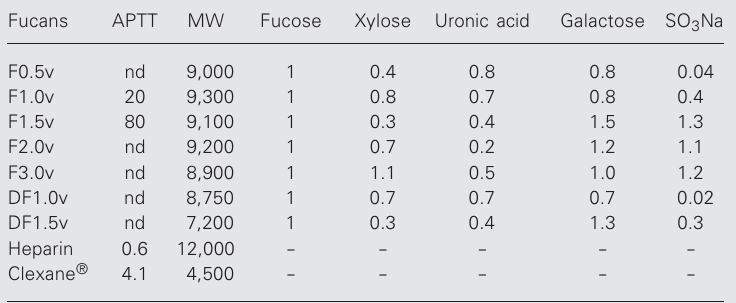
Table 1. Anticoagulant activity, molecular weight, and composition of the low molecu- lar weight fucans from Dictyota menstrualis . Fucans APTT MW Fucose Xylose Uronic acid Galactose SO 3 Na